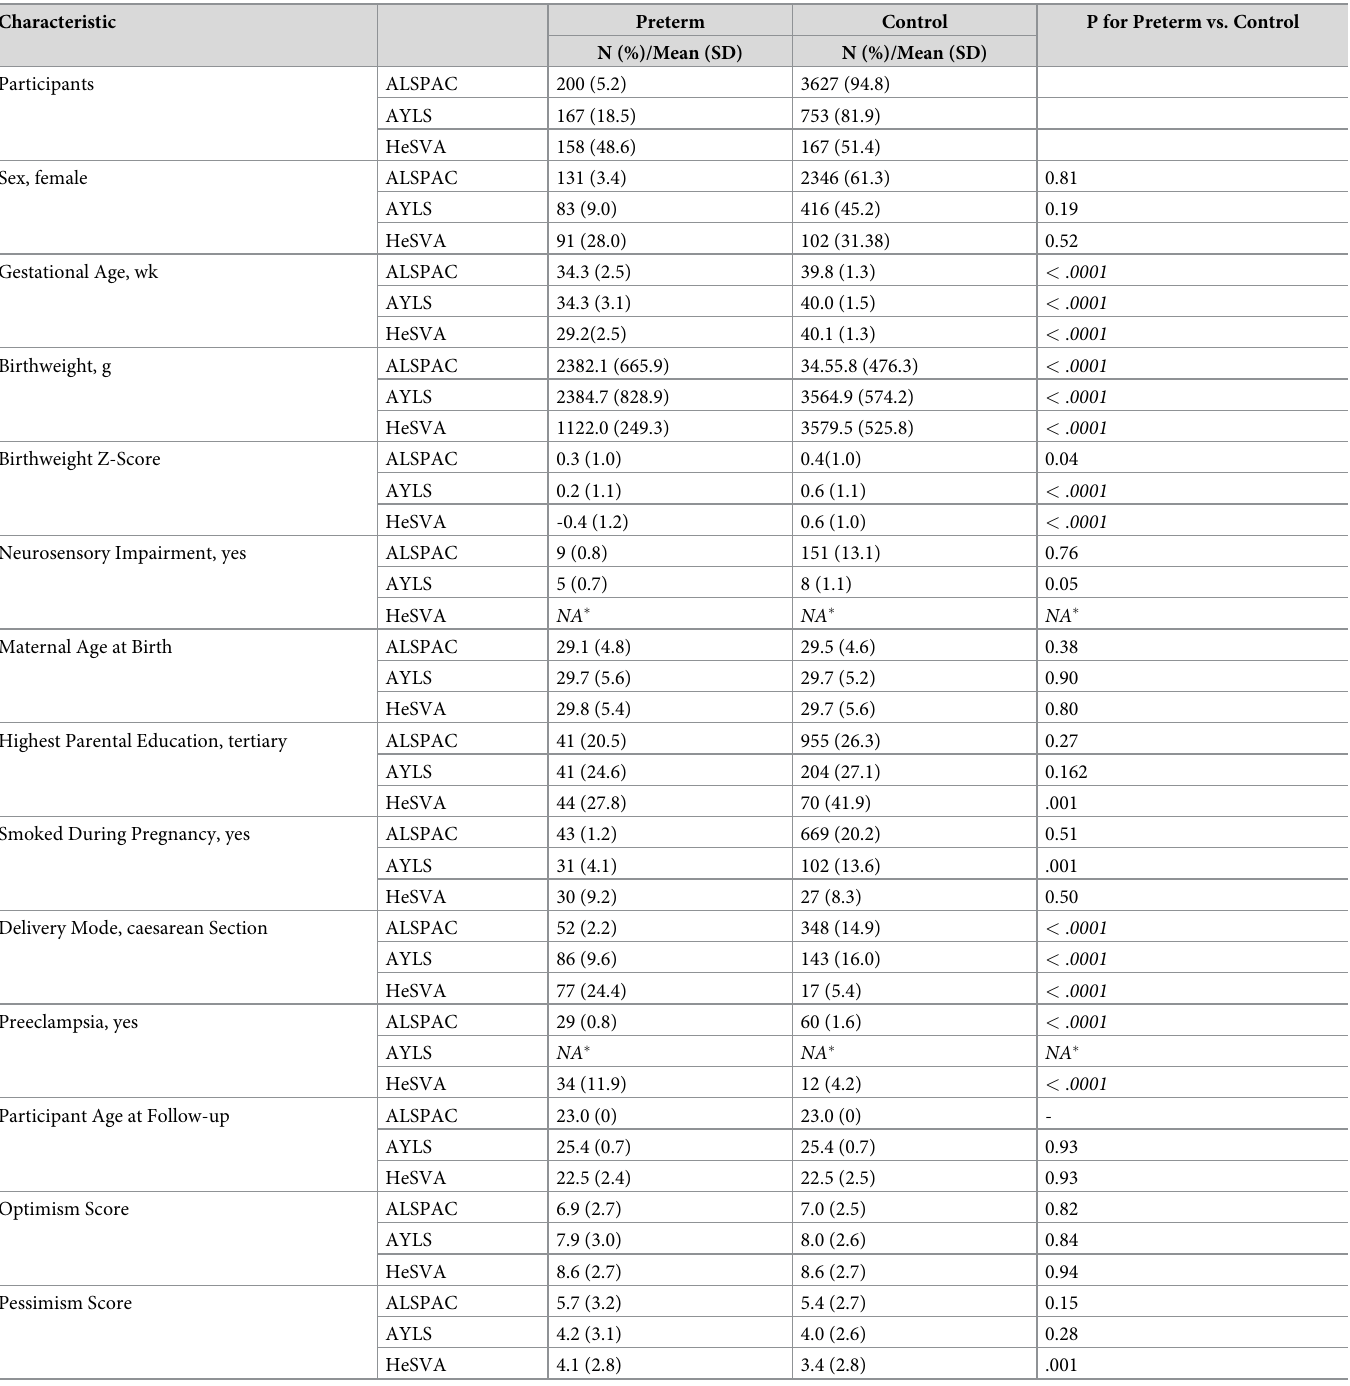
Table 1. Characteristics of participants by